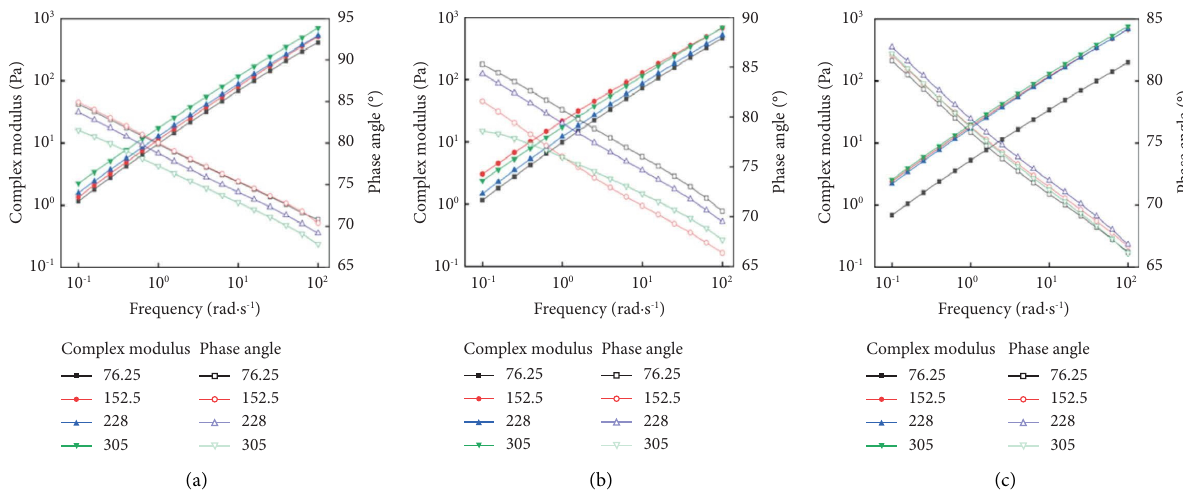
Figure 5: Variation curves of G ∗ and δ of diferent types of asphalt with UV aging time at 40 ° C. (a) 70#. (b) T770. (c) T622.